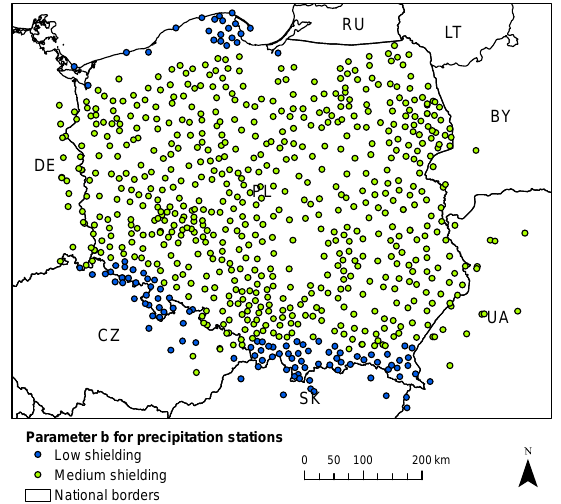
Figure 5. The Richter (1995) parameter b value groups for different precipitation